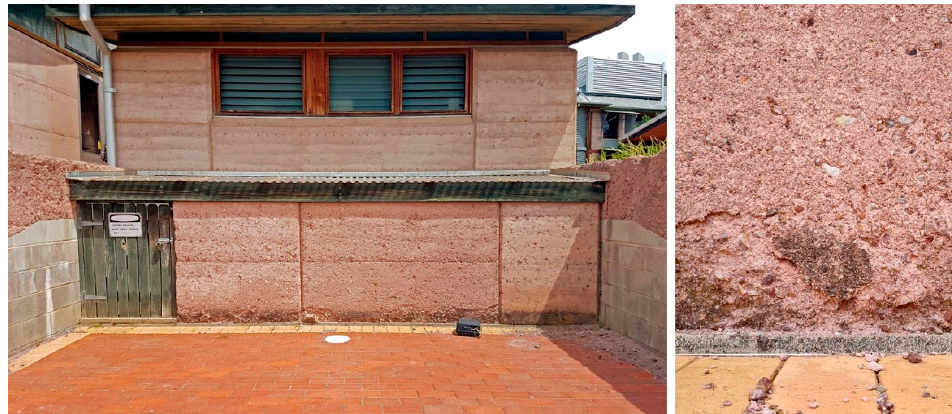
Figure 20. Paved space between wing walls 3 (left) and 4 (right) of Building 762. Note the decay at the base of the wall of the composting chamber.